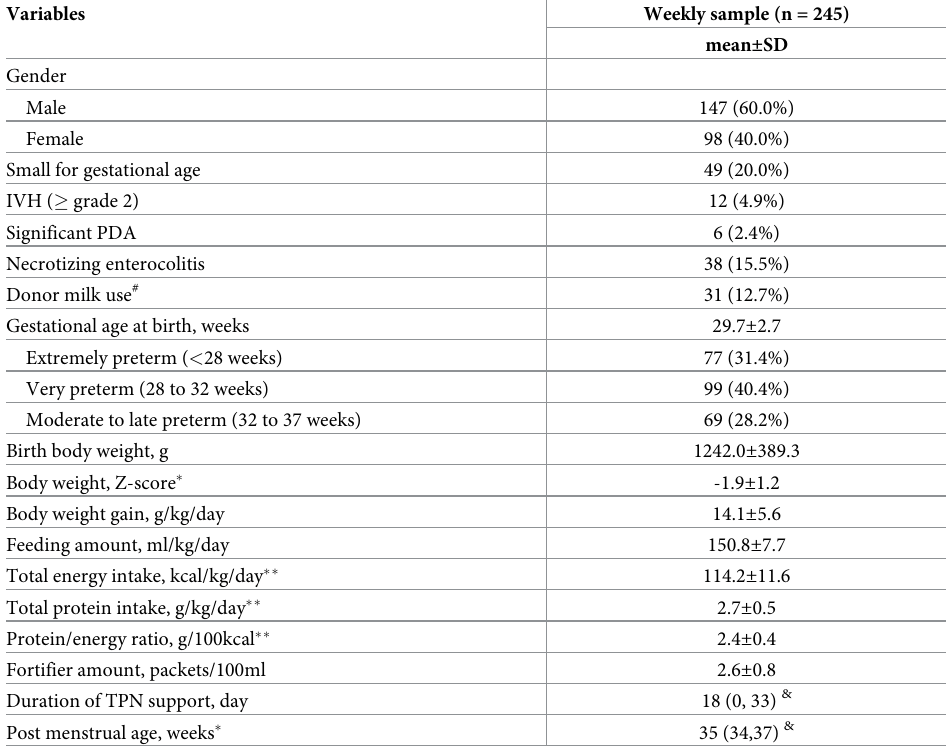
Table 1. Demographic data.